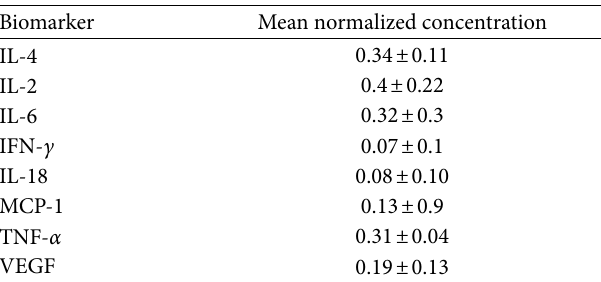
Figure 9: Immunolabeling of rat OM-MSCs (P5), Magnification: 600x: (a) AE1/AE3 (0); (b) Vimentin (+++); (c) CD31 (0); (d) Synaptophysin (+), (the black arrow highlights focal and membranous positive immunostaining); (e) c-Kit (++); (f); GFAP (+++). Insets show the respective negative controls for each immunomarker. Table 4: Mean normalized concentration of each biomarker in the CM of OM-MSCs (mean ±